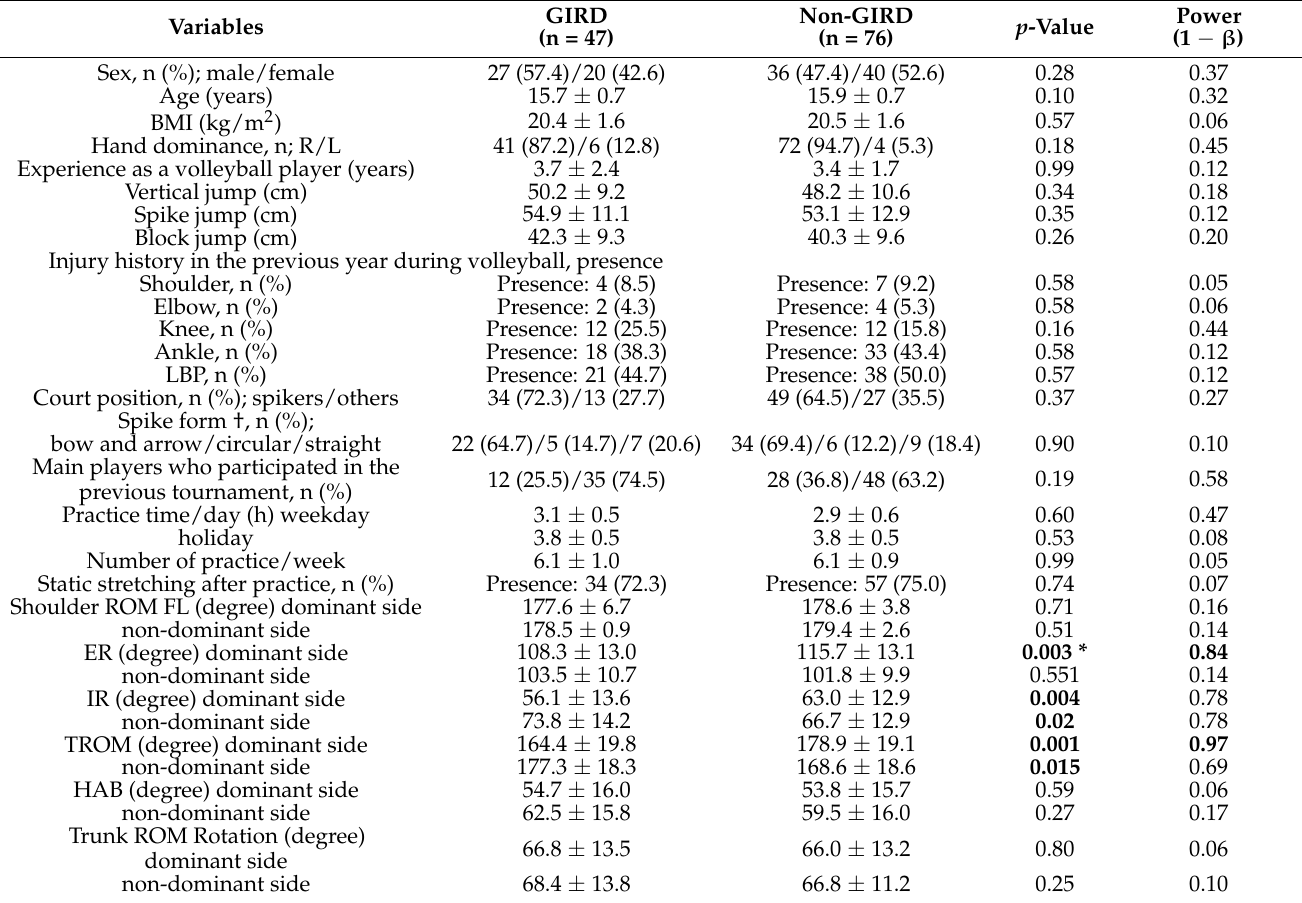
Table 3. Comparison of questionnaire and ROM between the GIRD and non-GIRD